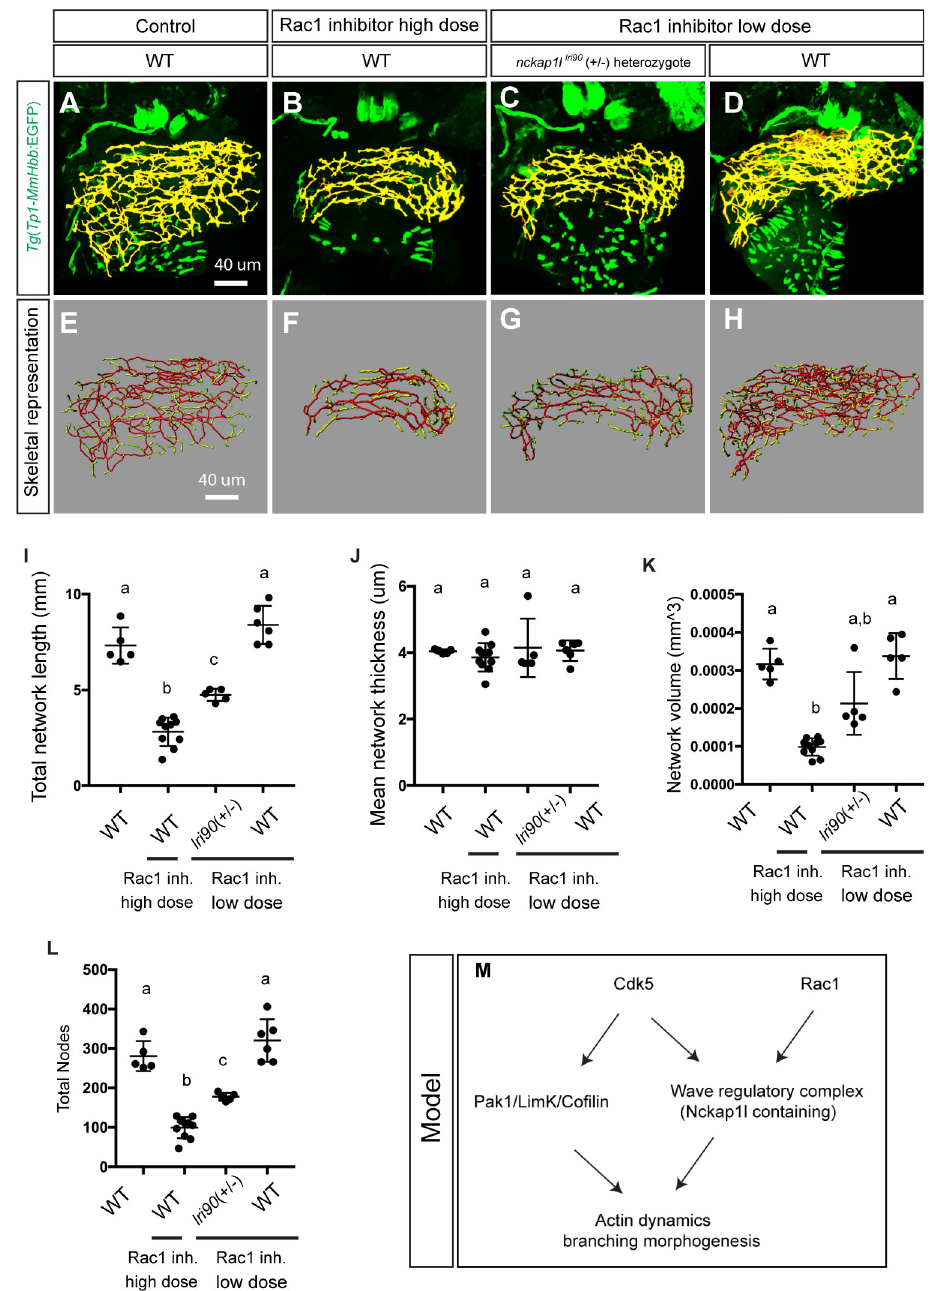
Fig 6. nckap1l dosage-dependent sensitization to Rac1 inhibitor treatment suggests that Nckap1l acts downstream of Rac1 to regulate intrahepatic biliary network branching morphogenesis. Wild-type and heterozygous nckap1l lri90 mutant larvae were treated with either high dose (50 ug/ml) or low dose (10 ug/ml) Rac1 inhibitor from 3 to 5 dpf, and then the treated larvae were analyzed at 5 dpf. (A-D) Projected confocal images of Tg (Tp1-MmHbb :EGFP ) um14 expression in control wild-type (A), high dose (50 ug/ml) Rac1 inhibitor-treated wild-type (B), low dose (10 ug/ml) Rac1 inhibitor-treated heterozygous nckap1l lri90 mutant (C), and low dose (10 ug/ml) Rac1 inhibitor-treated wild-type (D) larvae at 5 dpf. GFP expression in the intrahepatic biliary network is shown in pseudocolored yellow. (E-H) Skeletal representation of the intrahepatic biliary network in wild-type (E), 50 ug/ml Rac1 inhibitor-treated wild-type (F), 10 ug/ml Rac1 inhibitor-treated heterozygous nckap1l lri90 mutant (G), and 10 ug/ml Rac1 inhibitor-treated wild-type (H) larvae computed based on Tg(Tp1-MmHbb :EGFP ) um14 expression at 5 dpf. The end points (green), nodes (white), node-node connections (red), and node-end point connections (yellow) are colored separately. Ventral views, anterior to the top. (I-L) Computational analysis-based measurements of the